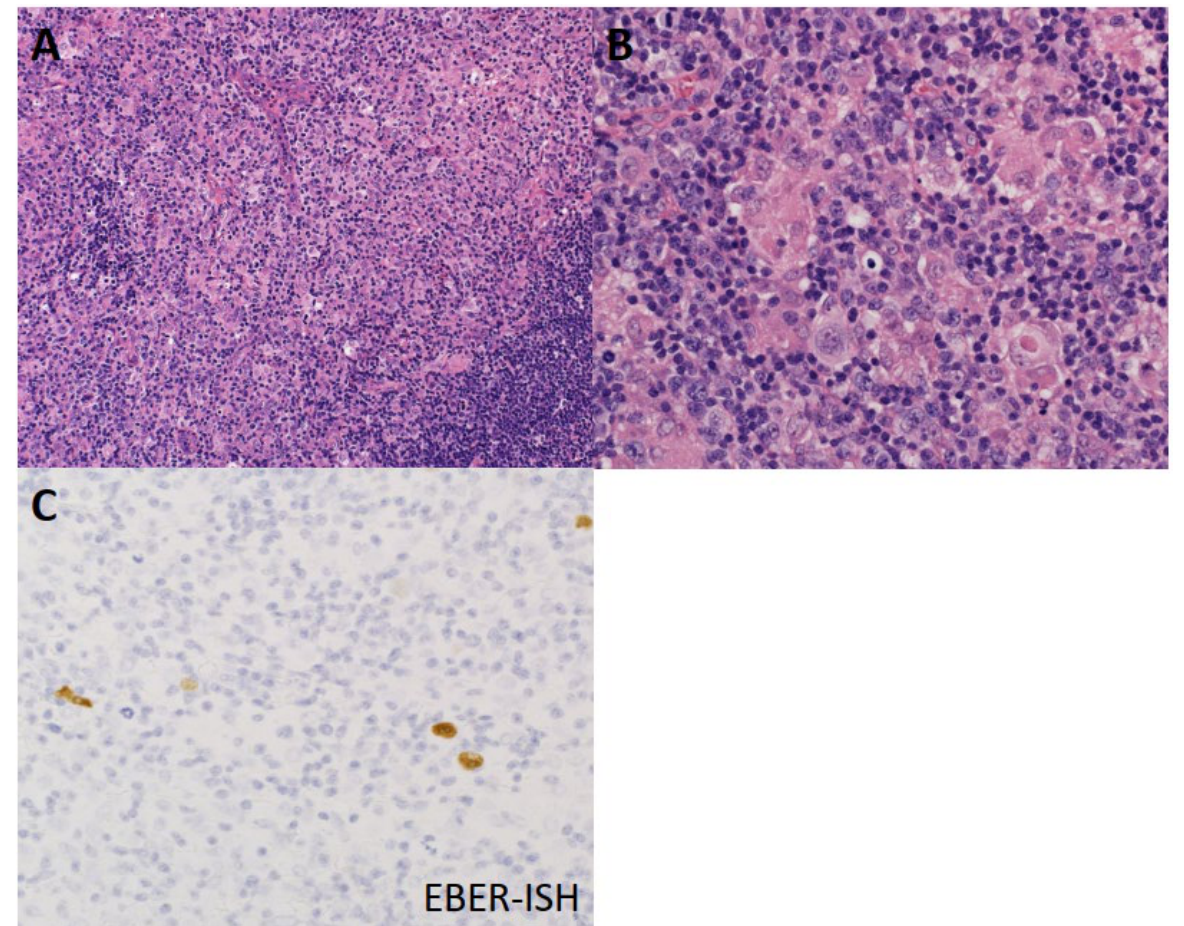
4 of 25 Figure 1. Histological and immunohistochemical features of nodular sclerosis classical Hodgkin lymphoma (NSCHL). ( A ) Cellular nodules are separated by collagen bundles. ( B ) Sclerotic thicken- ing of the lymph node capsule is shown. ( C ) Neoplastic cells that are binucleated with a “mirror-